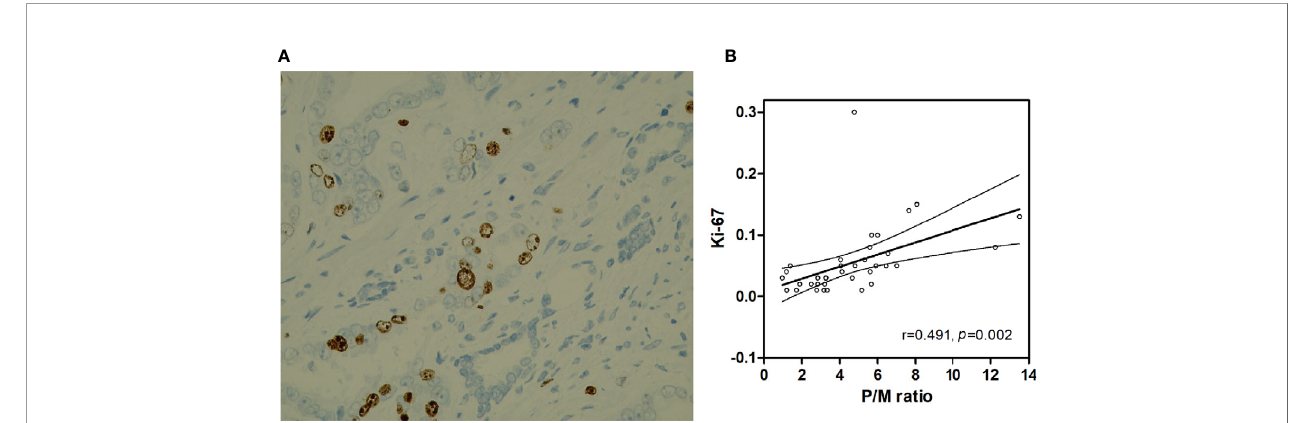
FIGURE 6 | (A) Prostate cancer (x400 HP fi eld), Ki-67 index is 10%. (B) Correlation between the Ki-67 and P/M ratio.